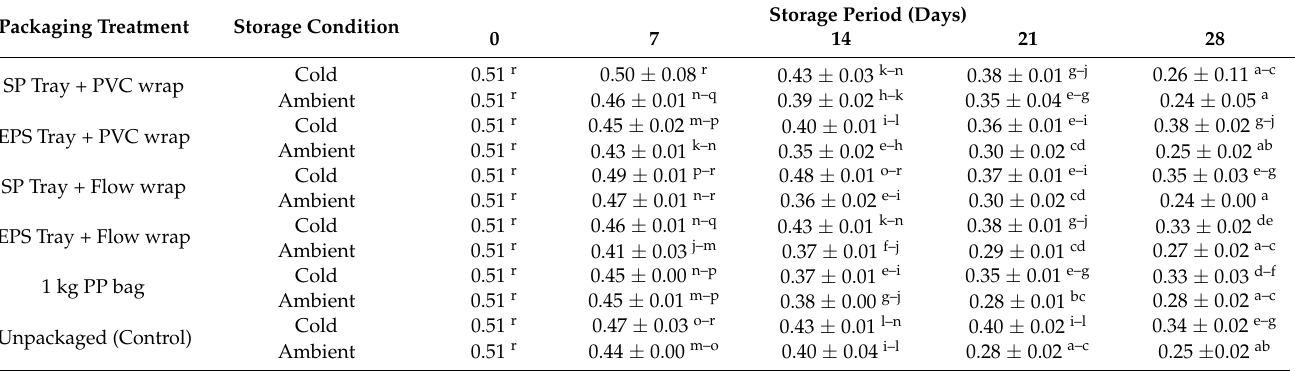
polystyrene: PVC = polyvinyl chloride: PP = polypropylene. Table 4. Titratable acidity (%) of the tomatoes is influenced by the packaging and storage conditions ( n =